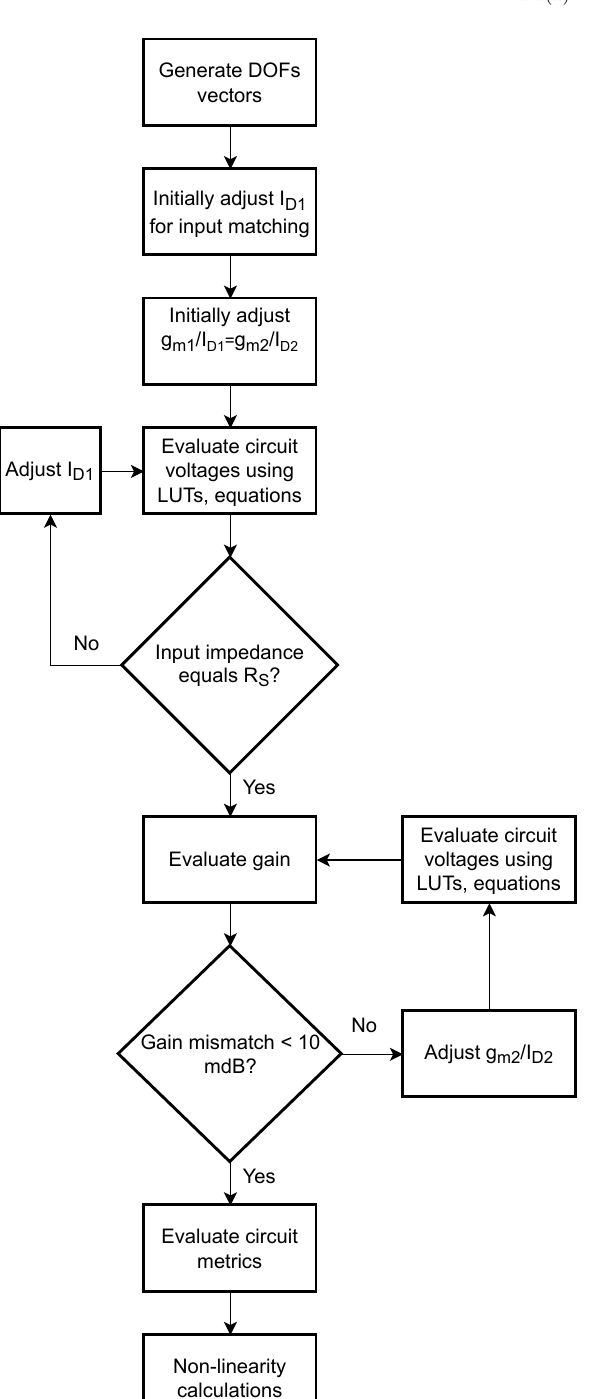
Figure 3. Proposed design procedure for the noise-canceling